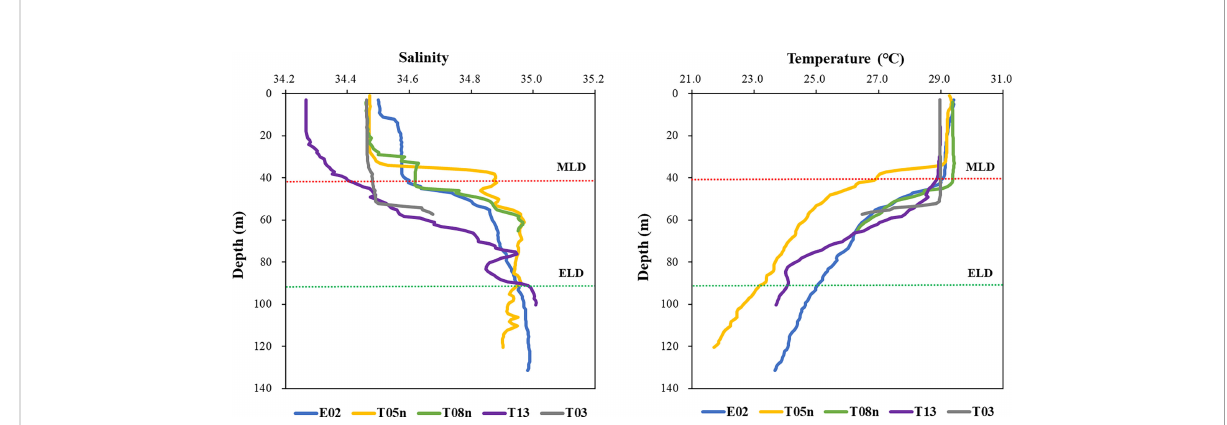
FIGURE 2 The pro fi les of salinity and temperature in the Philippines Sea, Northwestern Paci fi c Ocean. Red and green dash lines represent the average depths of mixed (MLD) and euphotic (ELD) layer,